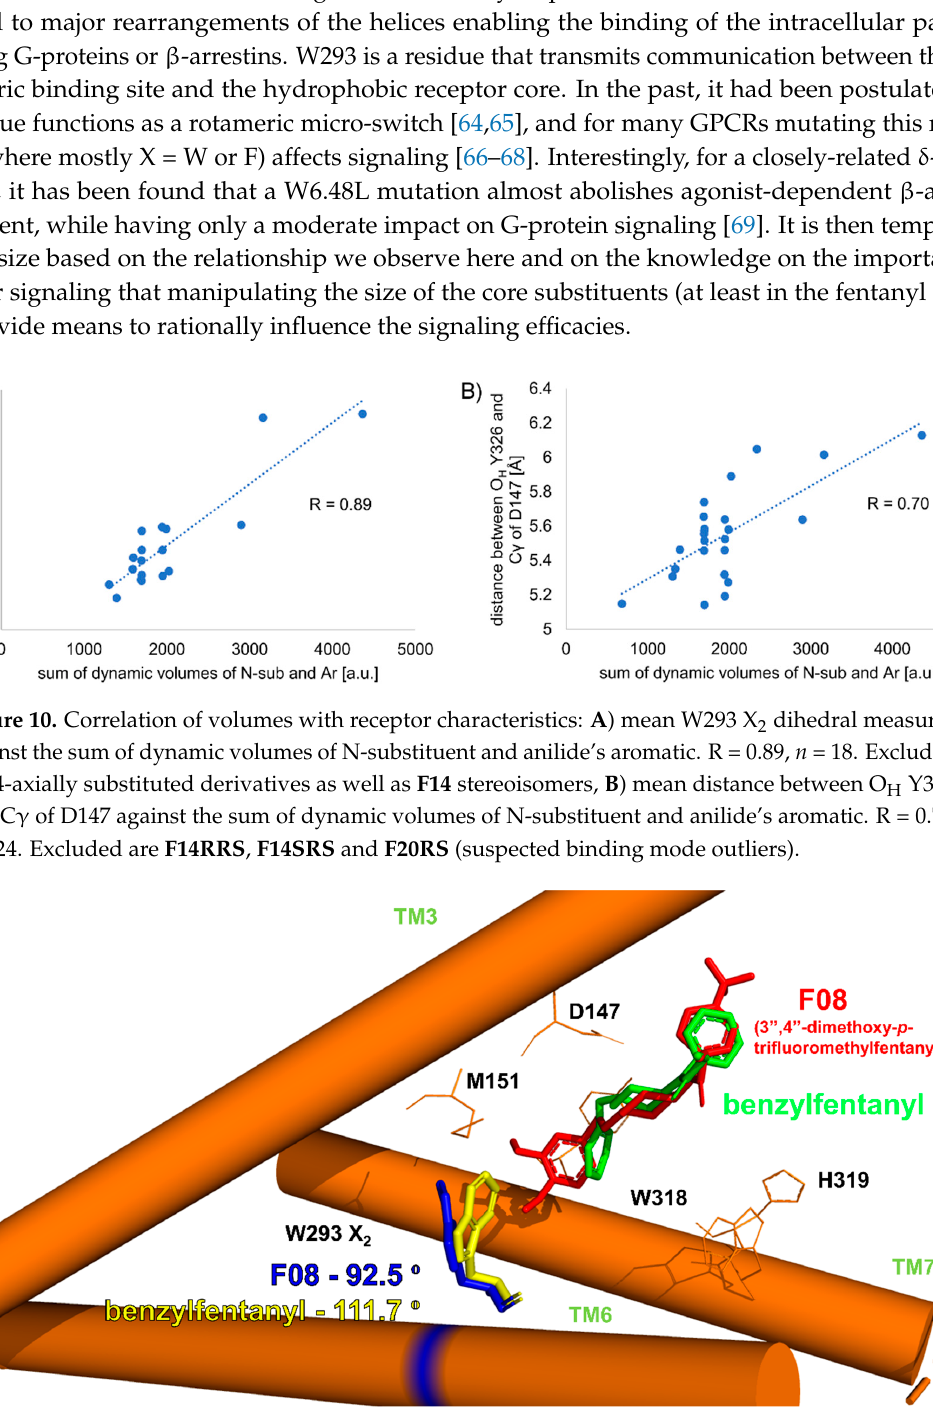
Figure 11. Average dihedral W293 X 2 for simulations with F08 (red ligand, blue W293) and benzylfentanyl ( F03 , green ligand, yellow W293) shown with the respective ligands and a simplified representation of μ OR binding site.